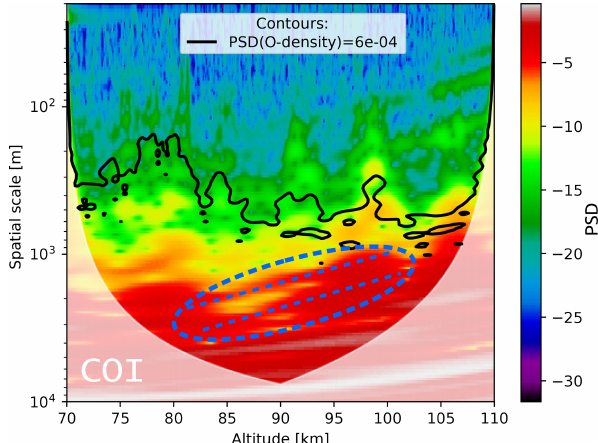
Figure 13. Wavelet spectrum of neutral density fluctuations as color contours. Black contour shows a constant power line taken from the wavelet spectrum of atomic oxygen density fluctuations (not shown here). White shading shows the cone of influence (COI). The dashed oval and two lines mark regions where the power peak shifts from large to small scales, which can be attributed to a GW saturation